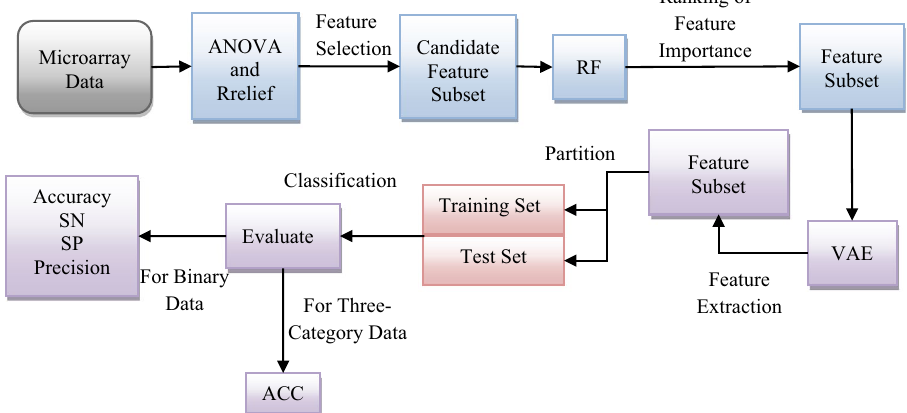
Fig. 1 Overall Structure of the